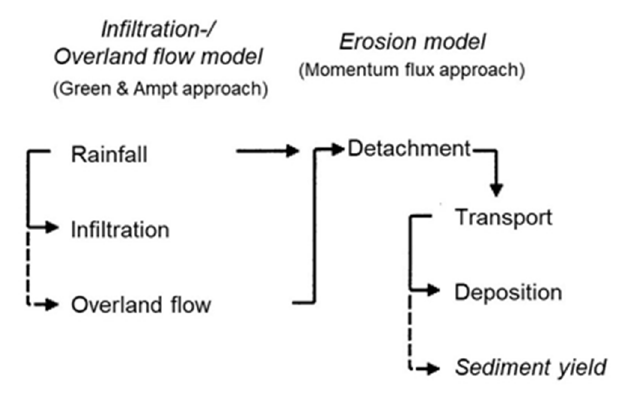
Figure 1. The EROSION-3D model structure [24].